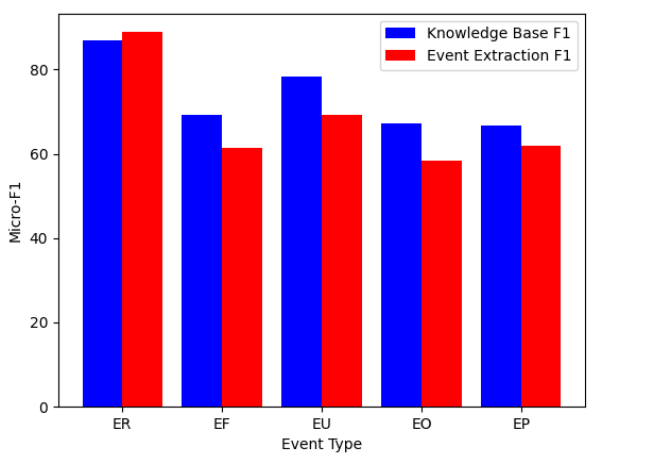
Figure 8. Comparison of knowledge base construction and event extraction model.